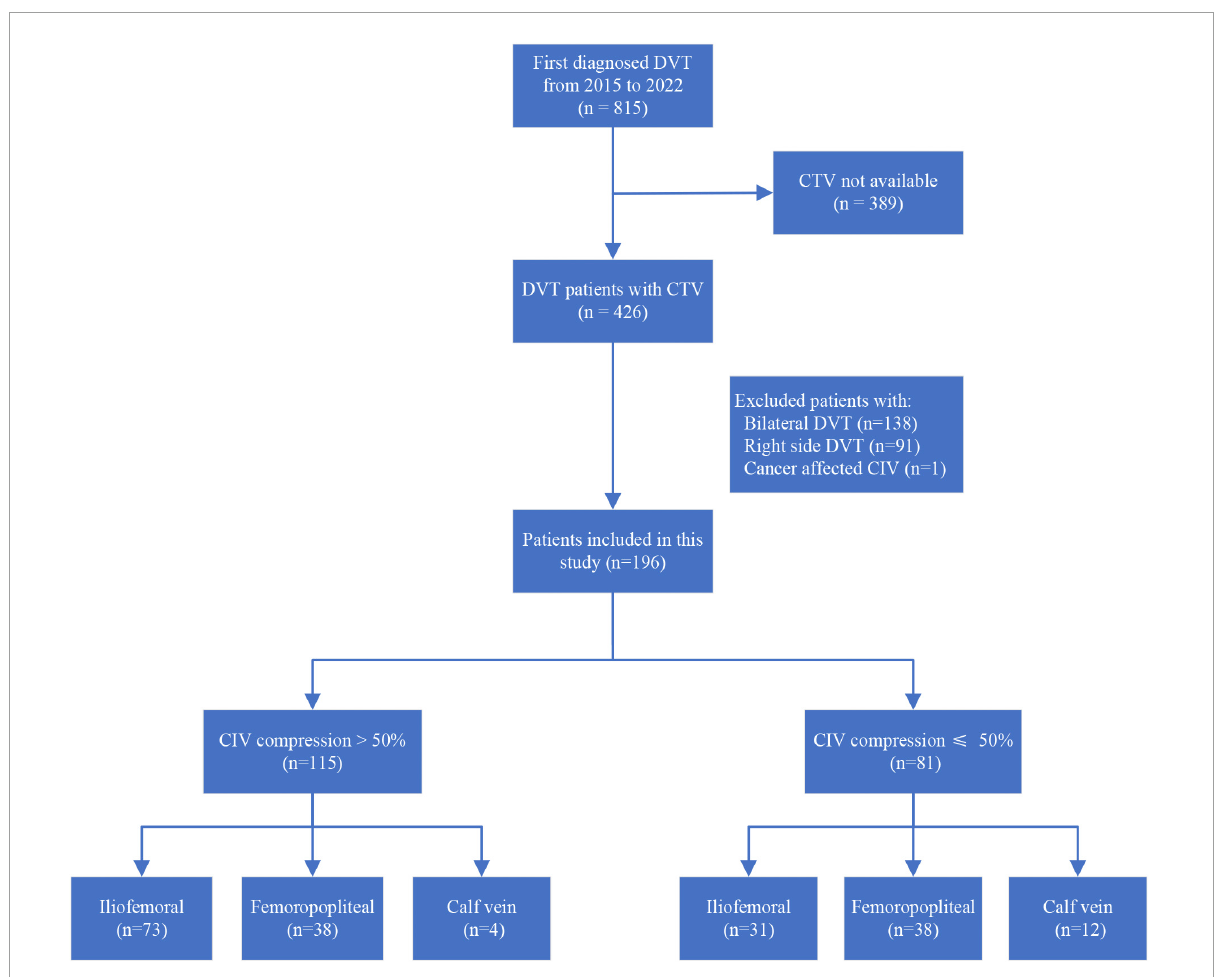
FIGURE2 Flowchart of patient inclusion and DVT levels in patients with CIV compression percentage > 50 or ≤ 50%. DVT, deep vein thrombosis; CTV, computed tomography venography; CIV, common iliac